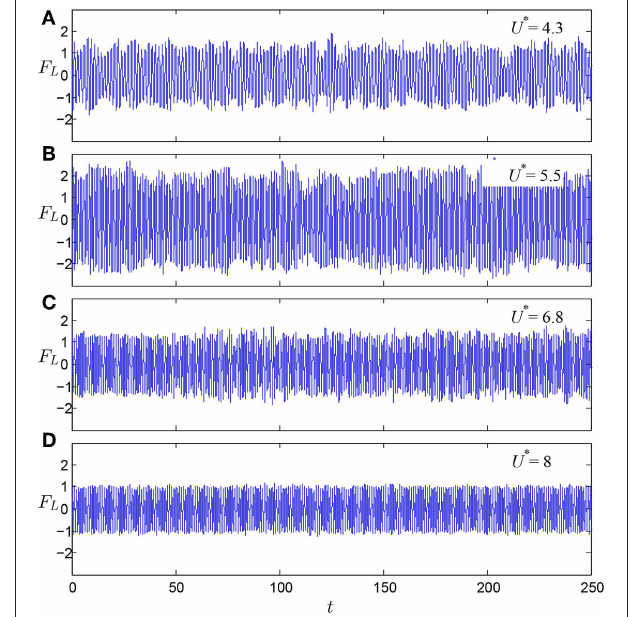
FIGURE 5 | Time series of the lift component at different reduced velocities: (A) U ∗ 4.3 (initial branch), (B) U ∗ 5.5 (upper branch), (C) U ∗ = = (transition), and (D) U ∗ 8 (lower =